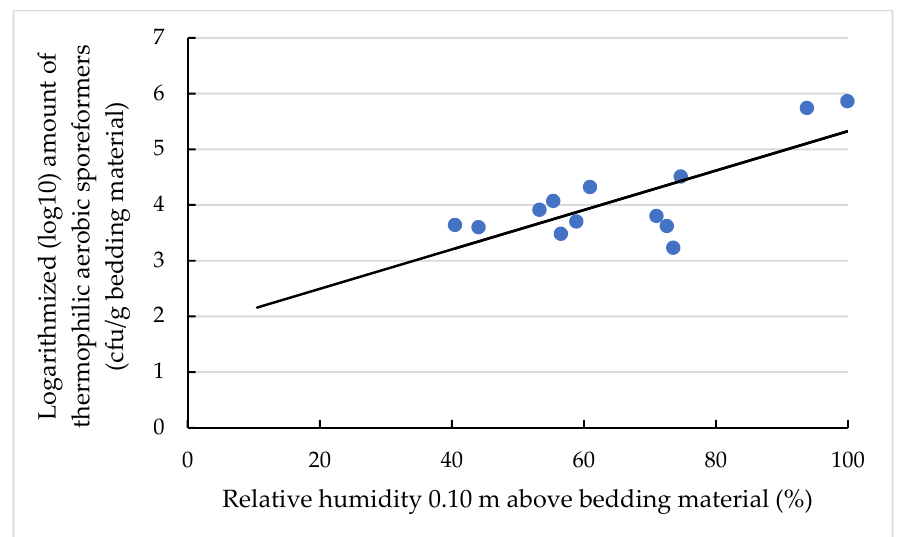
Figure 5. Levels of logarithmised (log10) amount (cfu/g bedding material) of TAS in dependency of relative humidity at the height of 0.10 m above the bedding material. The individual dots reflect the individual samples, and the black line is the regression line calculated with the equation y = − 0.04x + 1.79 and a coefficient of determination of 0.57.